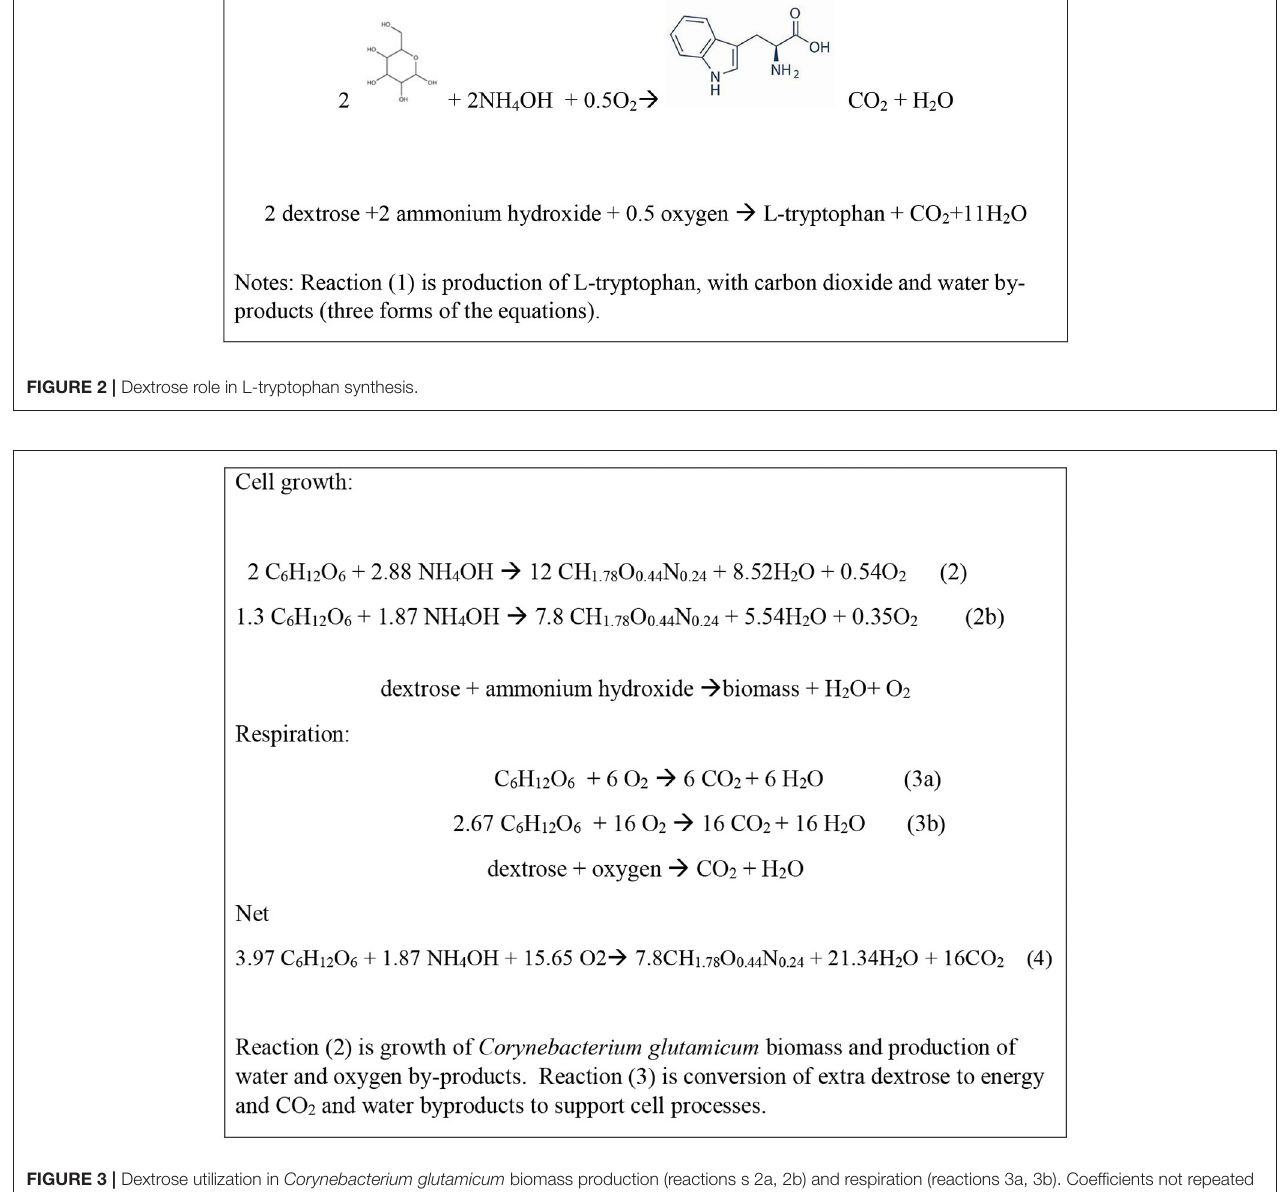
FIGURE 3 | Dextrose utilization in Corynebacterium glutamicum biomass production (reactions s 2a, 2b) and respiration (reactions 3a, 3b). Coefficients not repeated in word equations